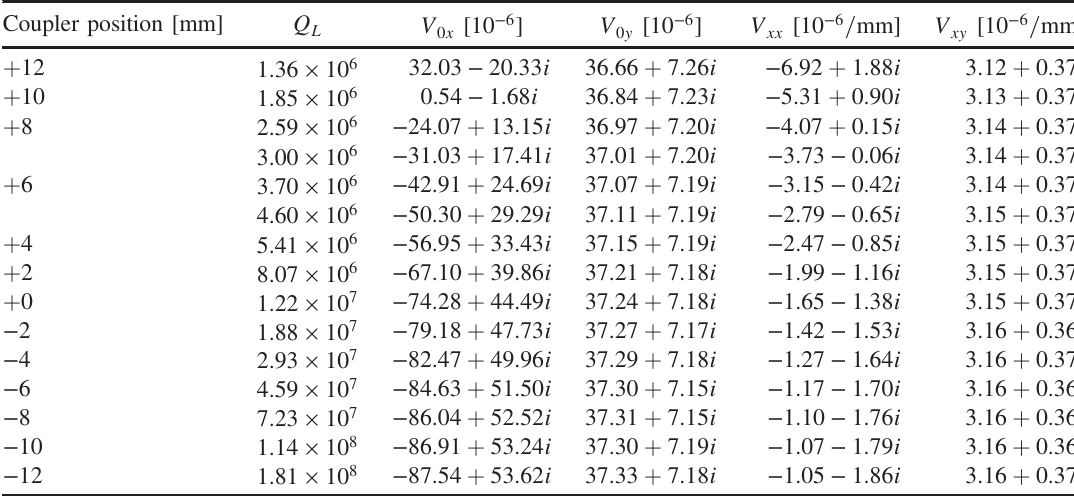
TABLE II. Coupler kick coefficients of the downstream coupler for the standing wave, V SW d [cf. Eq. (16)], as calculated with different field maps of the 1.3 GHz cavity for different values of the loaded quality factor Q L . The values for Q L ¼ 3 × 10 6 and Q L ¼ 4 . 6 × 10 6 reflect the standard Q L -setting for FLASH and European XFEL, respectively, and are evaluated using Eq. (18) and the fit parameters listed in Table IV.